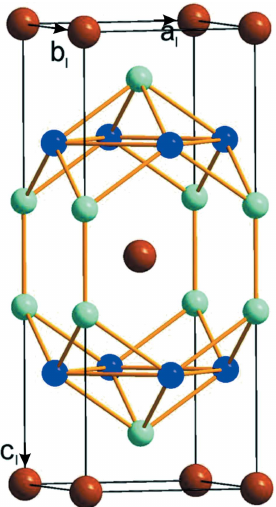
Figure 1 The crystal structure of EuAl 4 with the space group I 4/ mmm in the periodic phase at 250 K. Depicted is the I -centred unit cell with basis vectors a I , b I and c I . Brown spheres correspond to the Eu atoms, dark- blue spheres represent Al1 atoms and green spheres stand for Al2 atoms. The shortest interatomic distances are: d (Eu—Eu) = 4.3949 (2) A˚ , d (Al1—Al1) = 3.1077 (1) A˚ , d (Al2—Al1) = 2.664 (1) A˚ and d (Al2— Al2) = 2.568 (4) A˚